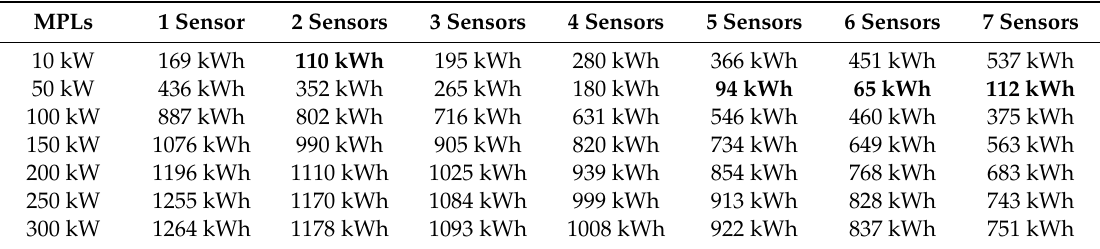
Table 4. Battery pack sizing for different PTO MPLs and loads in March.